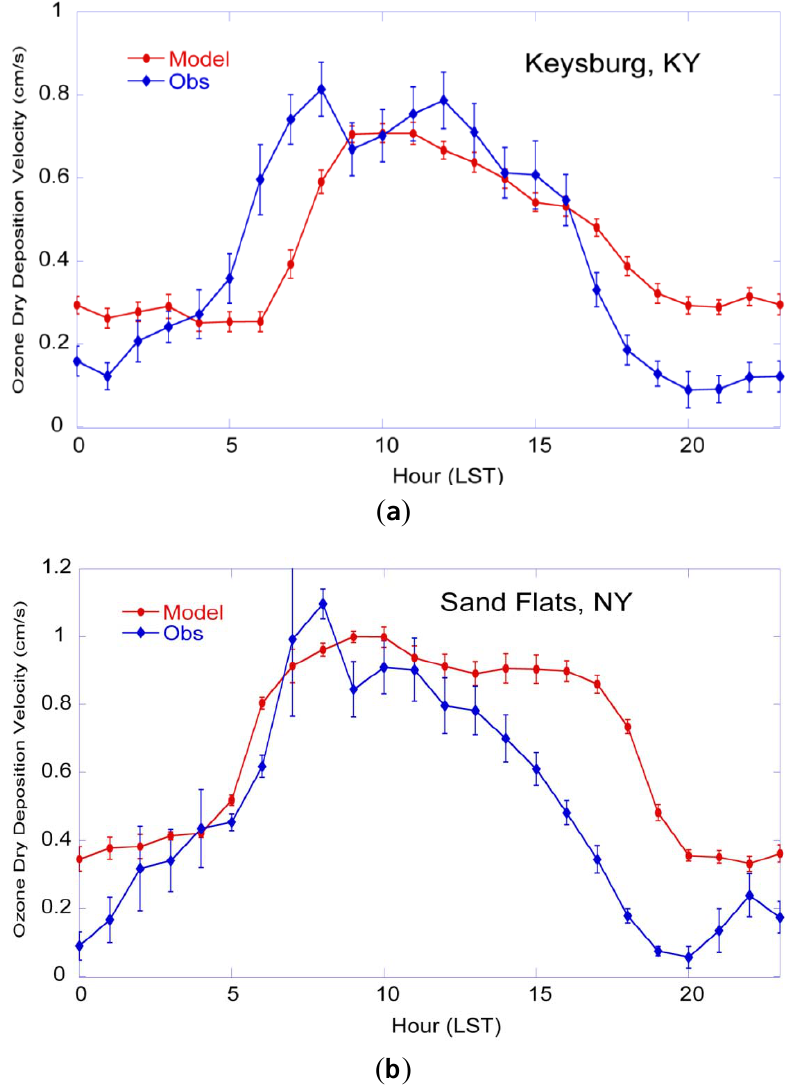
Figure 8. ( a ) Modeled and measured dry deposition velocity for ozone over soybean